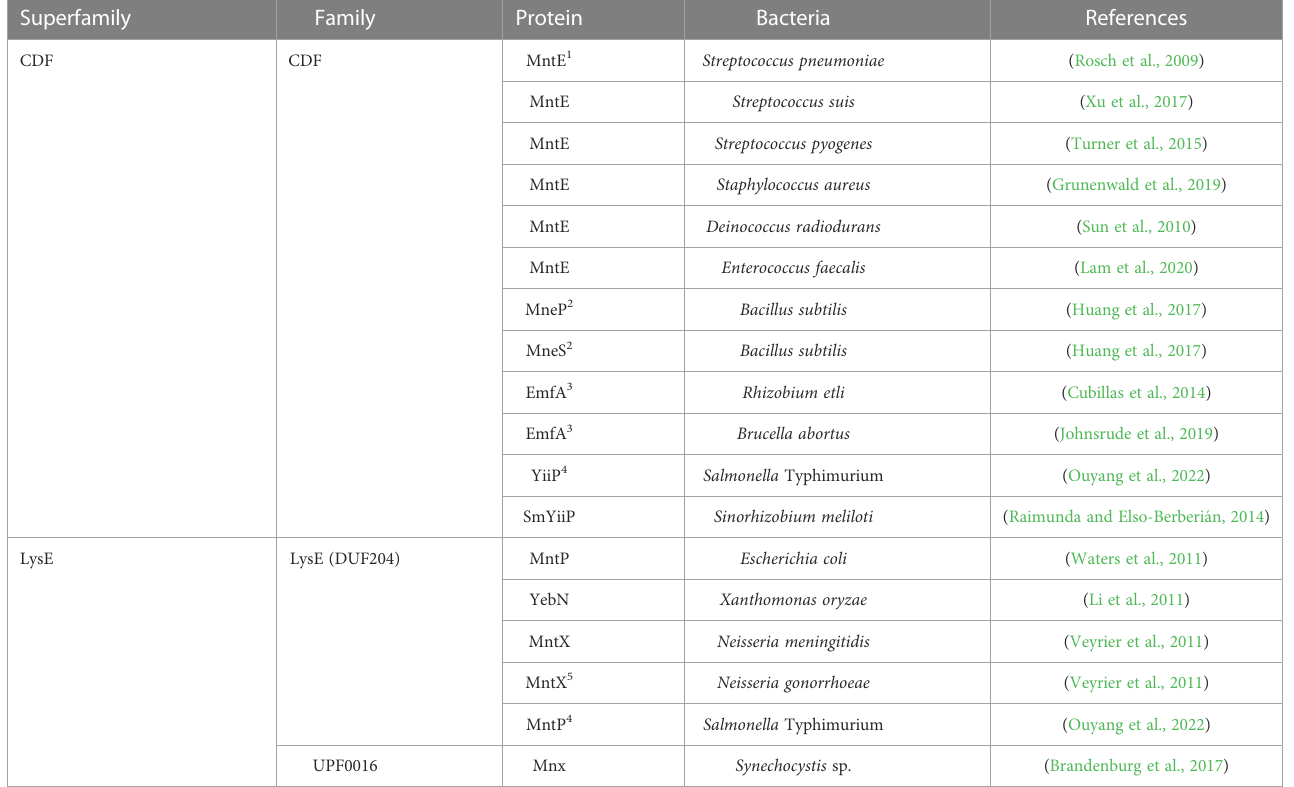
TABLE 1 Overview and classi fi cation of bacterial manganase exporters. Superfamily Family Protein